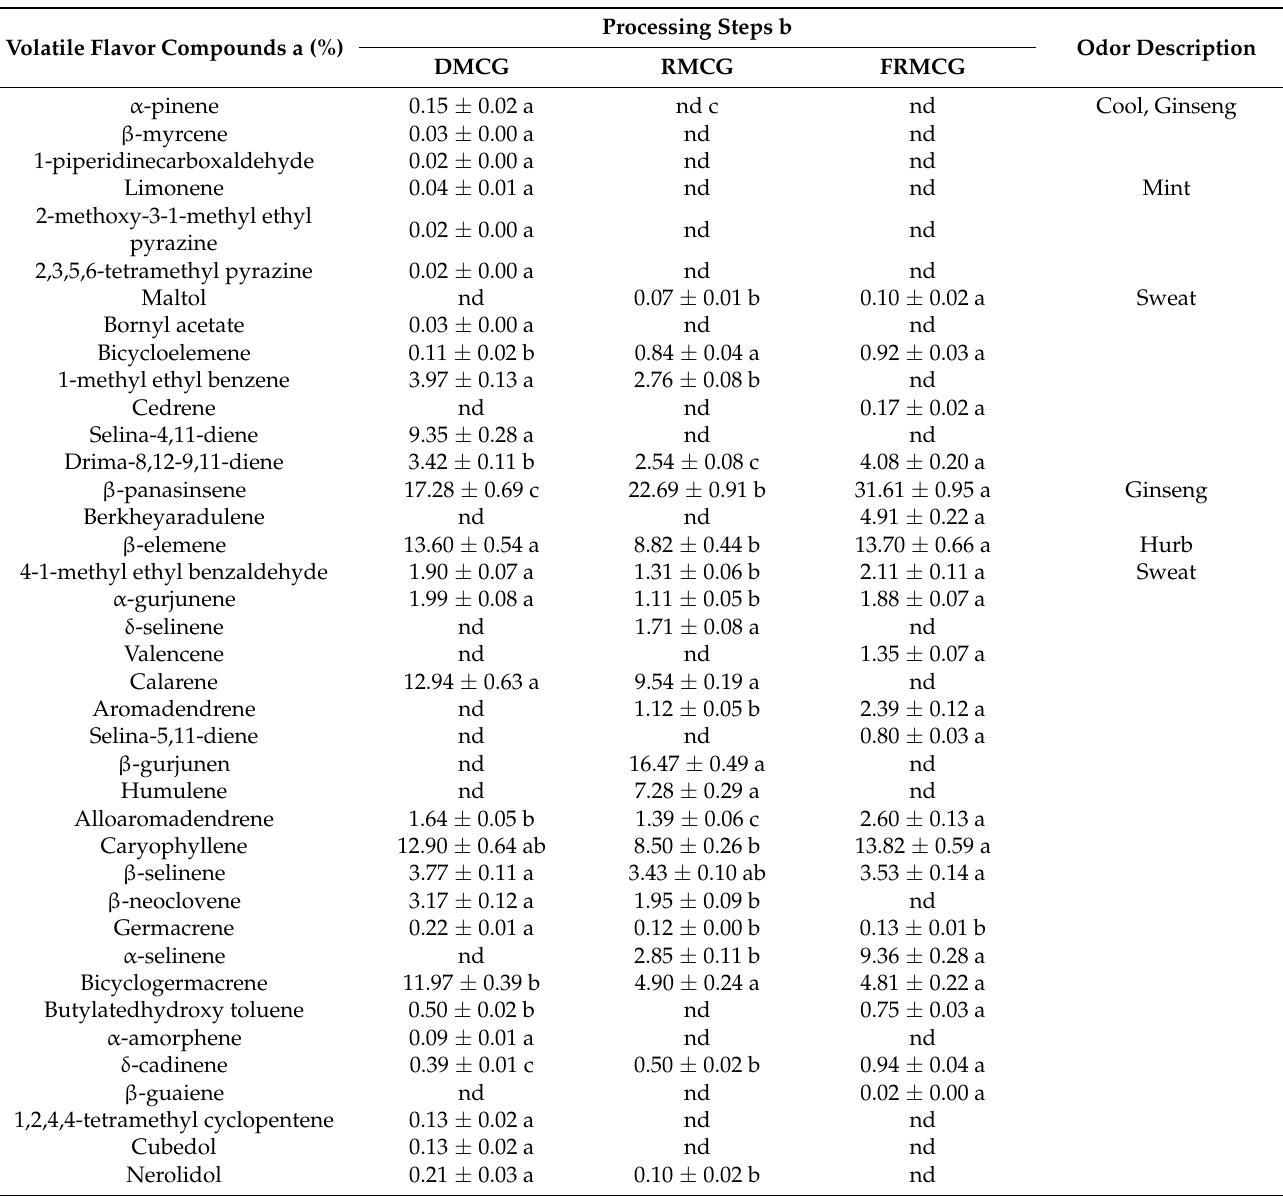
a—All values are presented as the mean ± SD of pentaplicate determination. Different letters correspond to the significant differences relating to the processing steps using Tukey’s multiple test ( p < 0.05). b—Processing